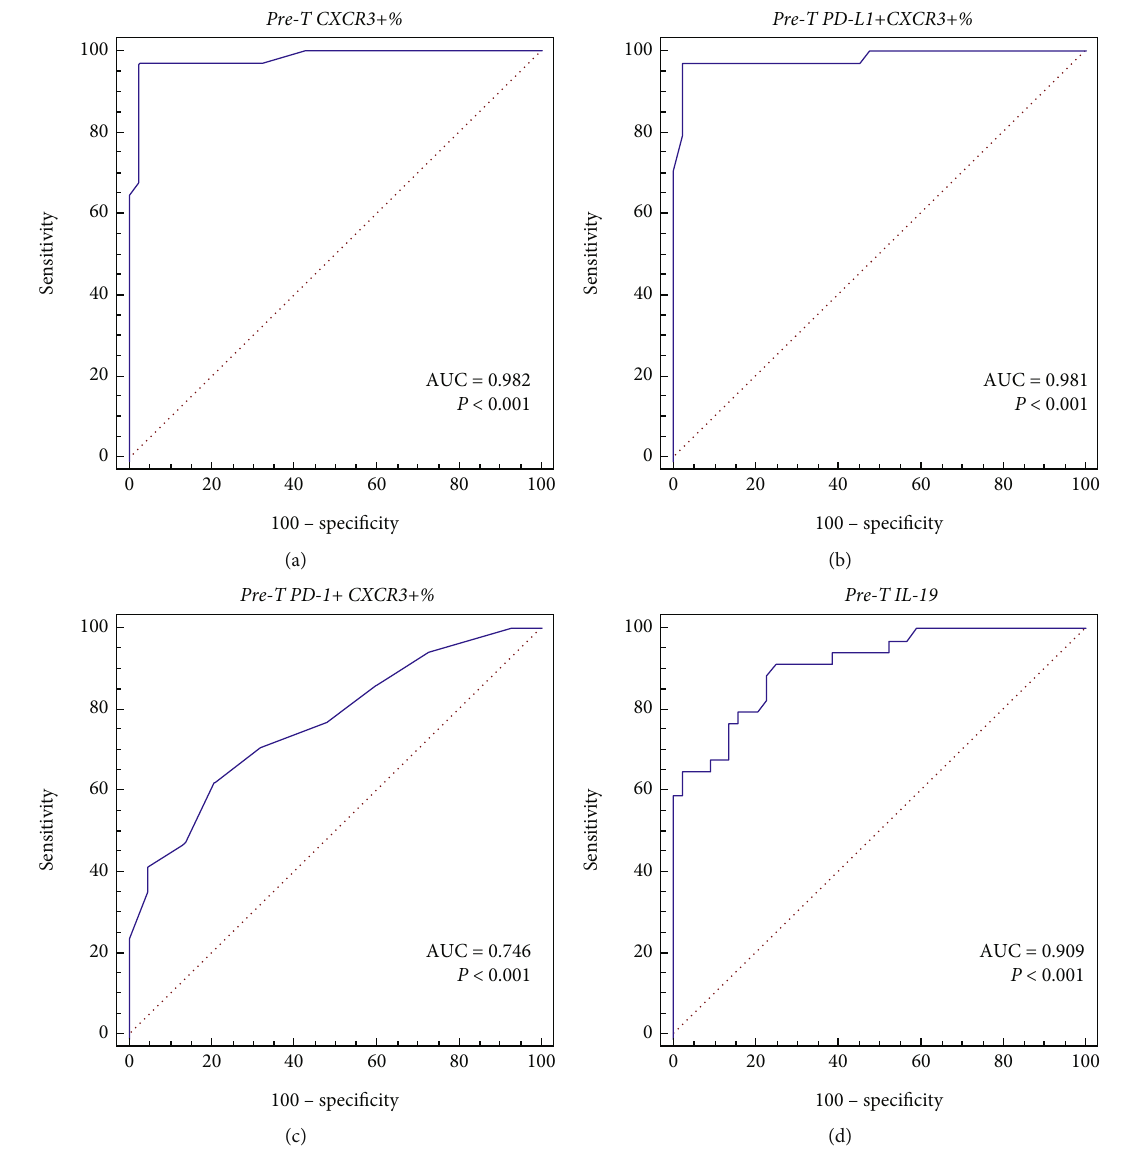
Figure 4: ROC curves of PD-L1/PD-1 coexpression with CXCR3/CD36 and IL-19 to predict extranodal involvement in lymphoma. (a) Pretherapy CXCR3+%. (b) Pretherapy PD-L1+CXCR3+%. (c) Pretherapy PD-1+CXCR3%. (d) Pretherapy